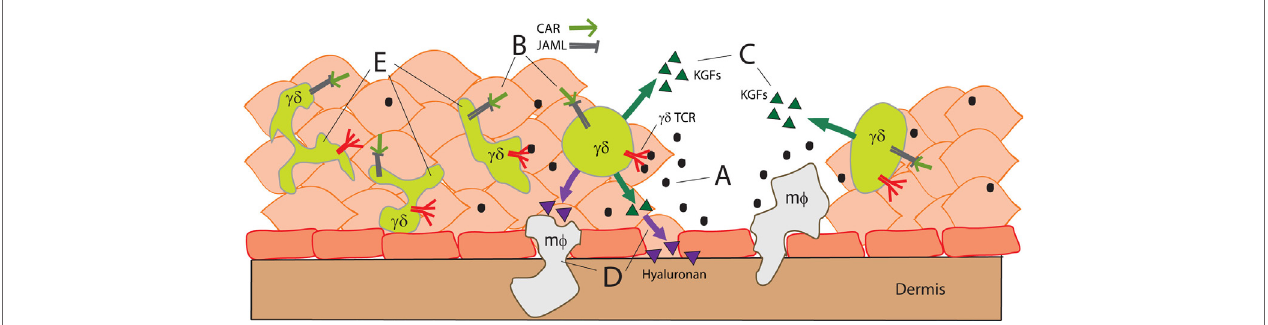
FiGURe 1 | Stress-related signals activate γδ T cells following trauma to epithelial tissues (A) . CAR–JAML interaction between keratinocytes and γδ T cells (B) costimulates γδ T cell activation. Activated γδ T cells secrete growth factors to initiate tissue repair (C) and trigger macrophage (m φ ) recruitment to assist in inflammation (D) . γδ T cells proximal to the wound site have fewer dendrites and appear more rounded (e)